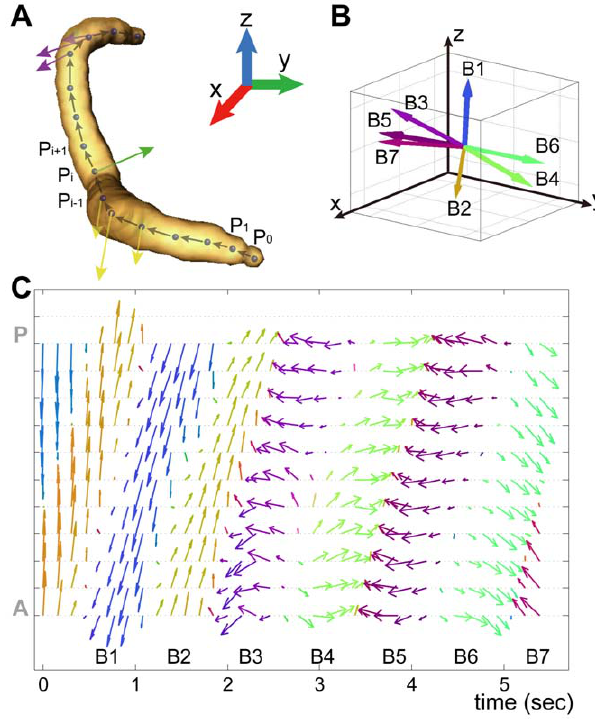
Figure 5. Bending vector analysis of worm motion. (A) Schematic of the bending vector in a 3-D skeleton. The arrows indicate the bending vector at a skeletal point, P i . (B) Variable bending vectors of a second skeletal point from the head of a representative worm during crawling. (C) The X-Y projections of bending vectors along the whole body for 5.5 s of crawling. The colors of arrows represent the directions of the bending vectors by linearly converting the components of normalized bending vectors ( 2 1.0 , 1.0) to 8-bit colors (0 , 255): the X- component is displayed in red (R), the Y-component in green (G), and the Z-component in blue (B).